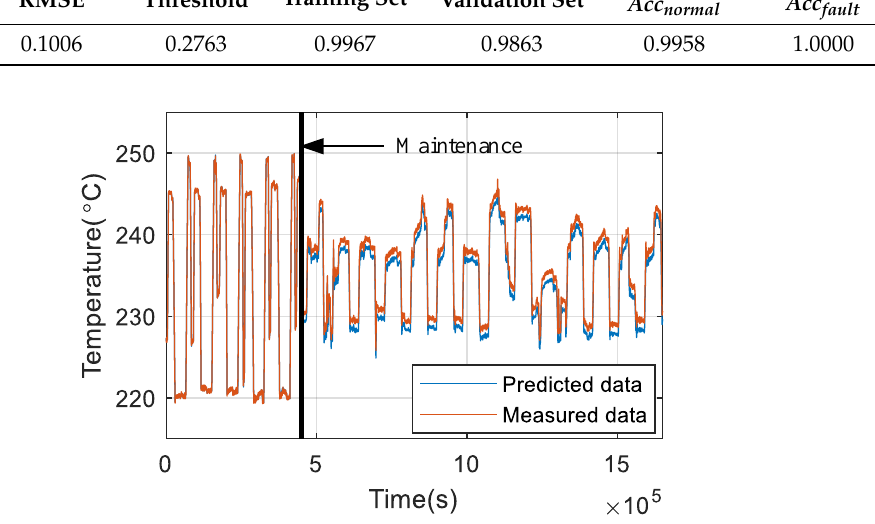
Figure 18. Performance in fault early warning set.